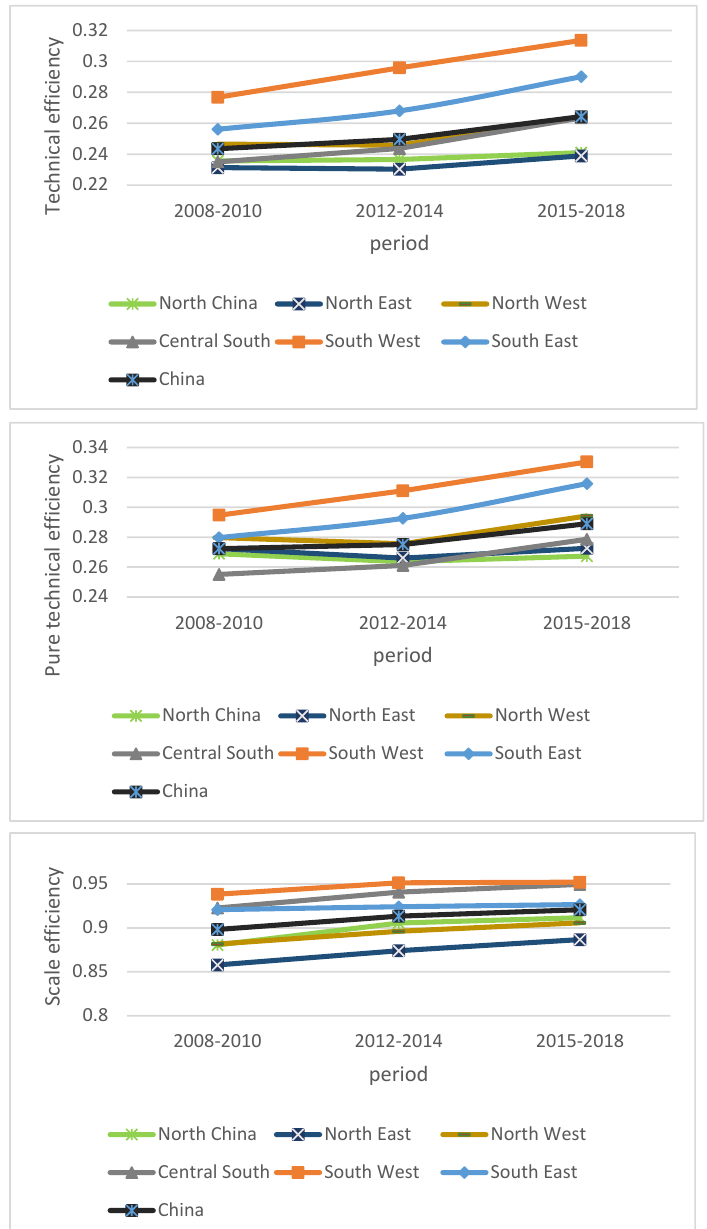
Figure 2. Mean of technical efficiency, pure technical efficiency, and scale efficiency of state-owned forest farms in China from 2008 to 2018 (Efficiency value after excluding external environmental factors of state-owned forest farms for the third stage).